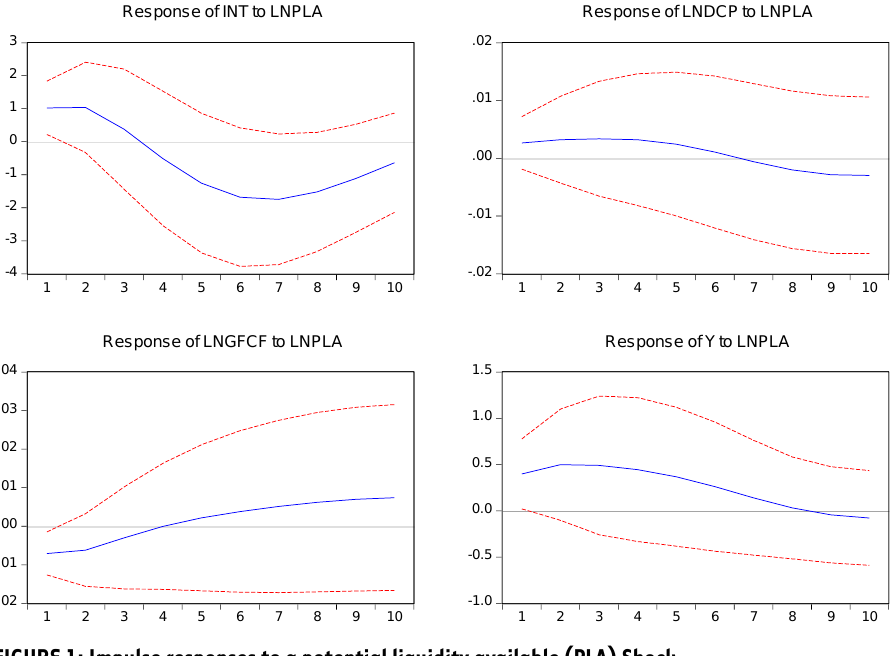
FIGURE 1: Impulse responses to a potential liquidity available (PLA) Shock PLA: Potential Liquidity Available; INT: Real Interest Rate; DCP: Domestic Credit to Private Sector; GFCF: Gross Fixed Capital Formation; Y: GDP